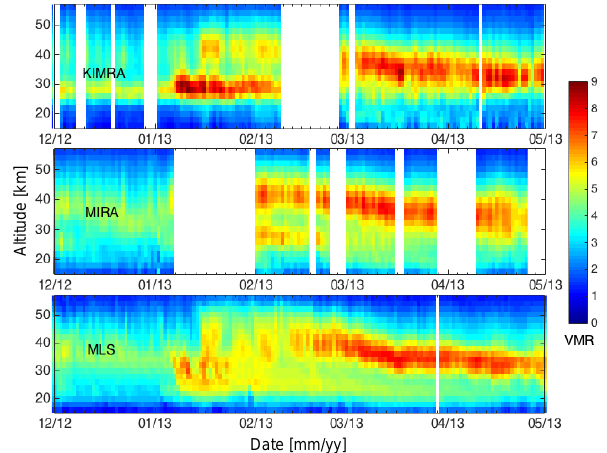
Figure 12. Time series of the daily average O 3 profiles (in ppmv) for KIMRA, MIRA 2, and unsmoothed MLS measurements.